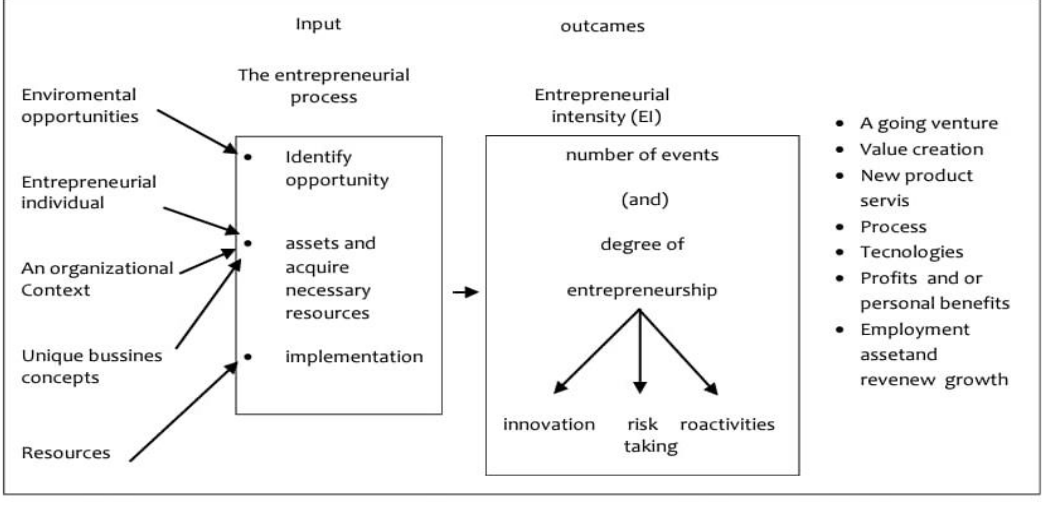
Figure 2: Entrepreneurship Integrative Model; Source: Kuratko,